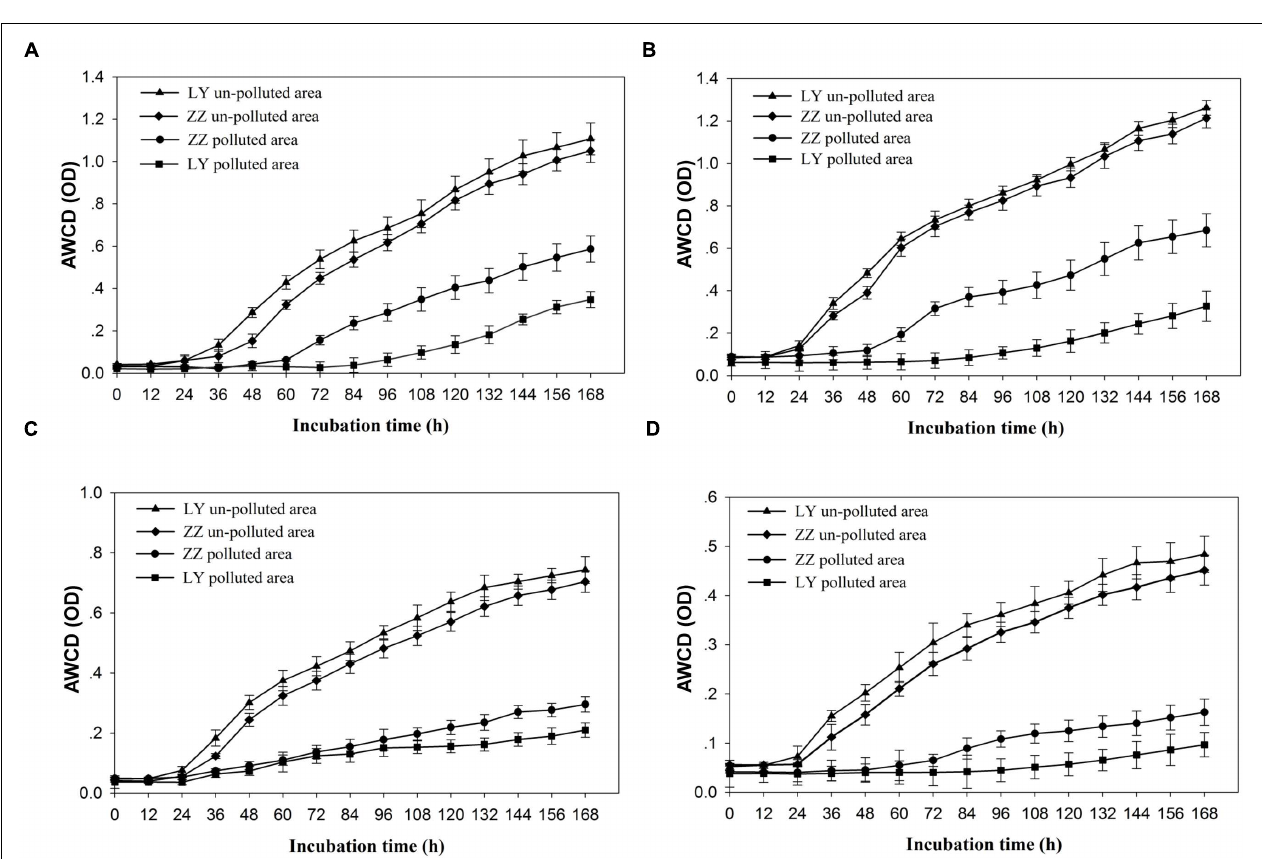
FIGURE 2 | Utilization of four kinds of carbon sources by soil microbial community from different sampling areas. (A–D) Representing the amino acid and its derivates (AD), sugar and its derivates (SD), fatty acid and its derivates (FD), or secondary metabolites (SM), and average well color development (AWCD) indicating the average value of three replicated results of one Biolog-Ecoplate. LY and ZZ mean Liuyang and Zhuzhou City, respectively.